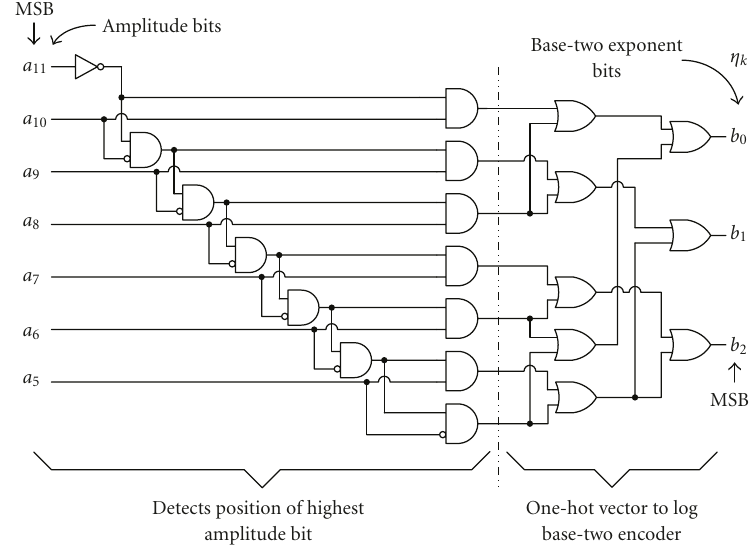
Figure 7: Circuit that generates the base-two exponent η k